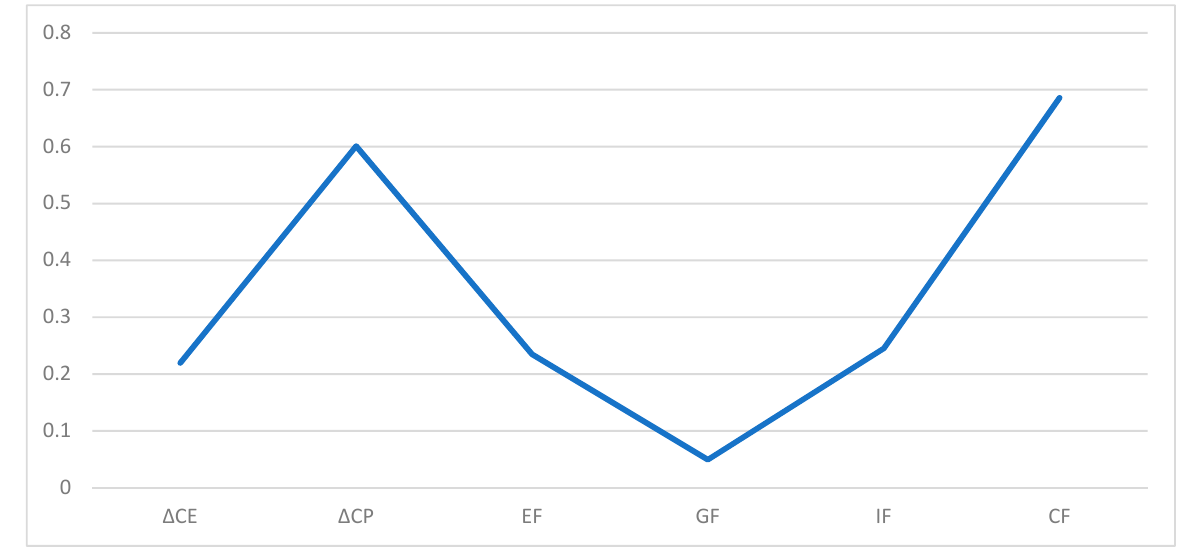
Figure 2. Historical trends over the period of time.